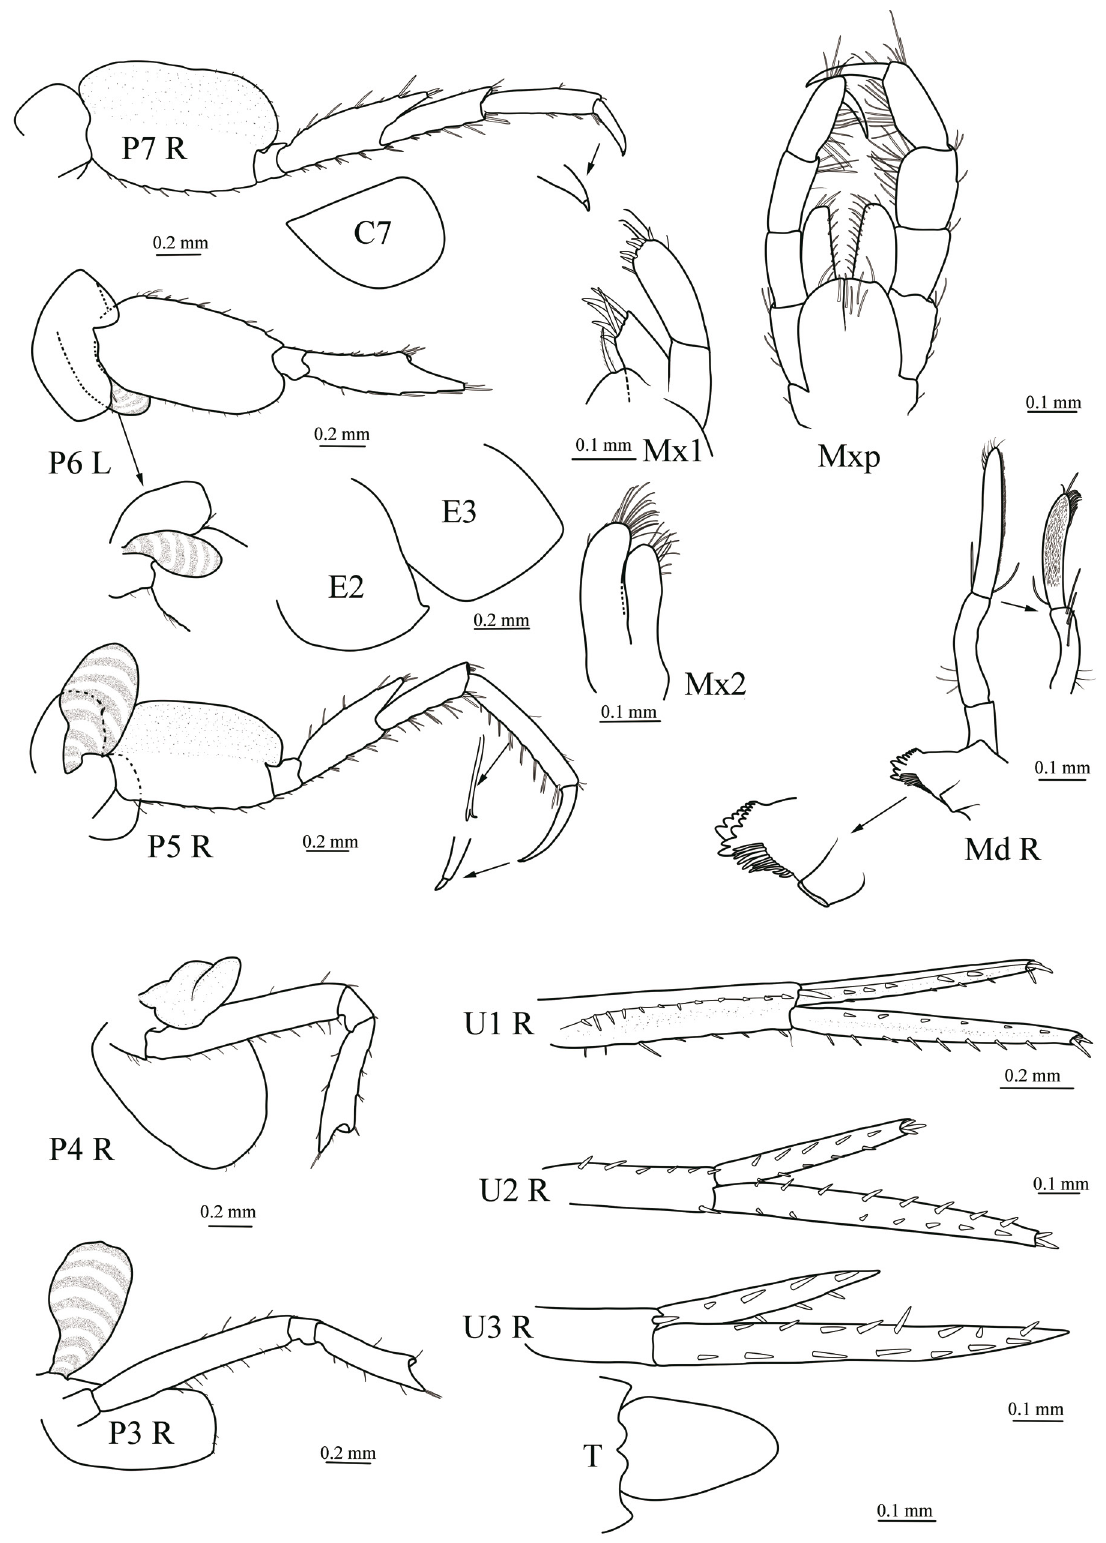
Fig. 2. Bathya brevicarpus gen. et sp. nov., holotype, ♂ (MBM